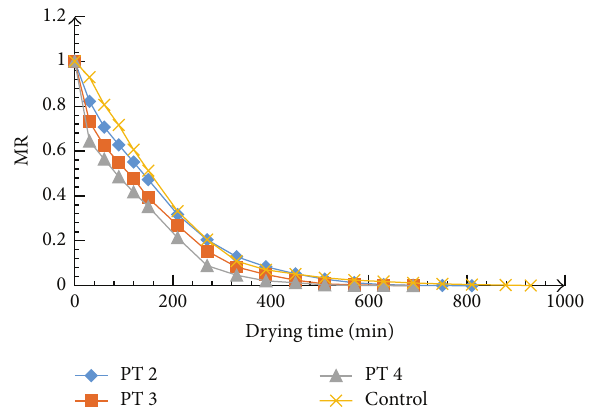
Figure 2: Variation of MR versus drying time at microwave power 450 W.